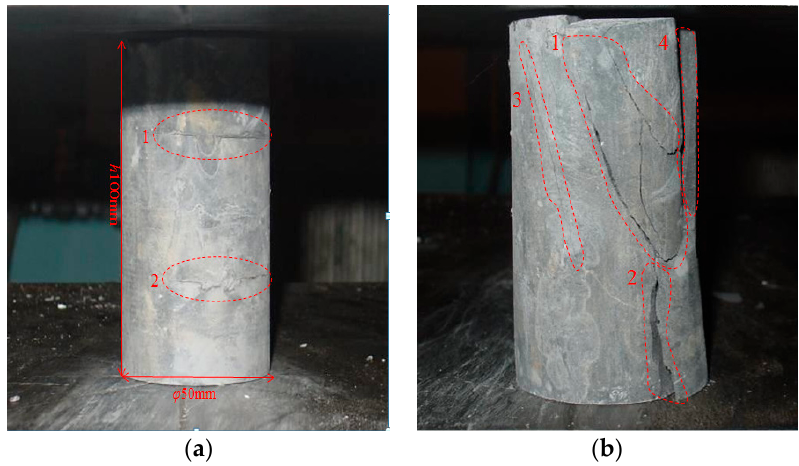
Figure 5. Comparison before and after uniaxial compression test of clastic limestone: ( a ) Before compression test; ( b ) After compression test.